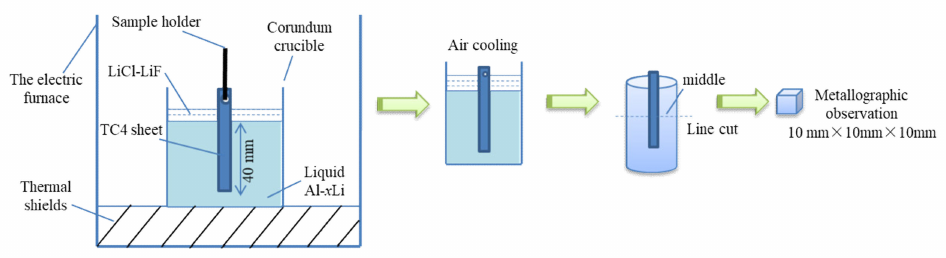
Figure 1. Schematic diagram of the experimental